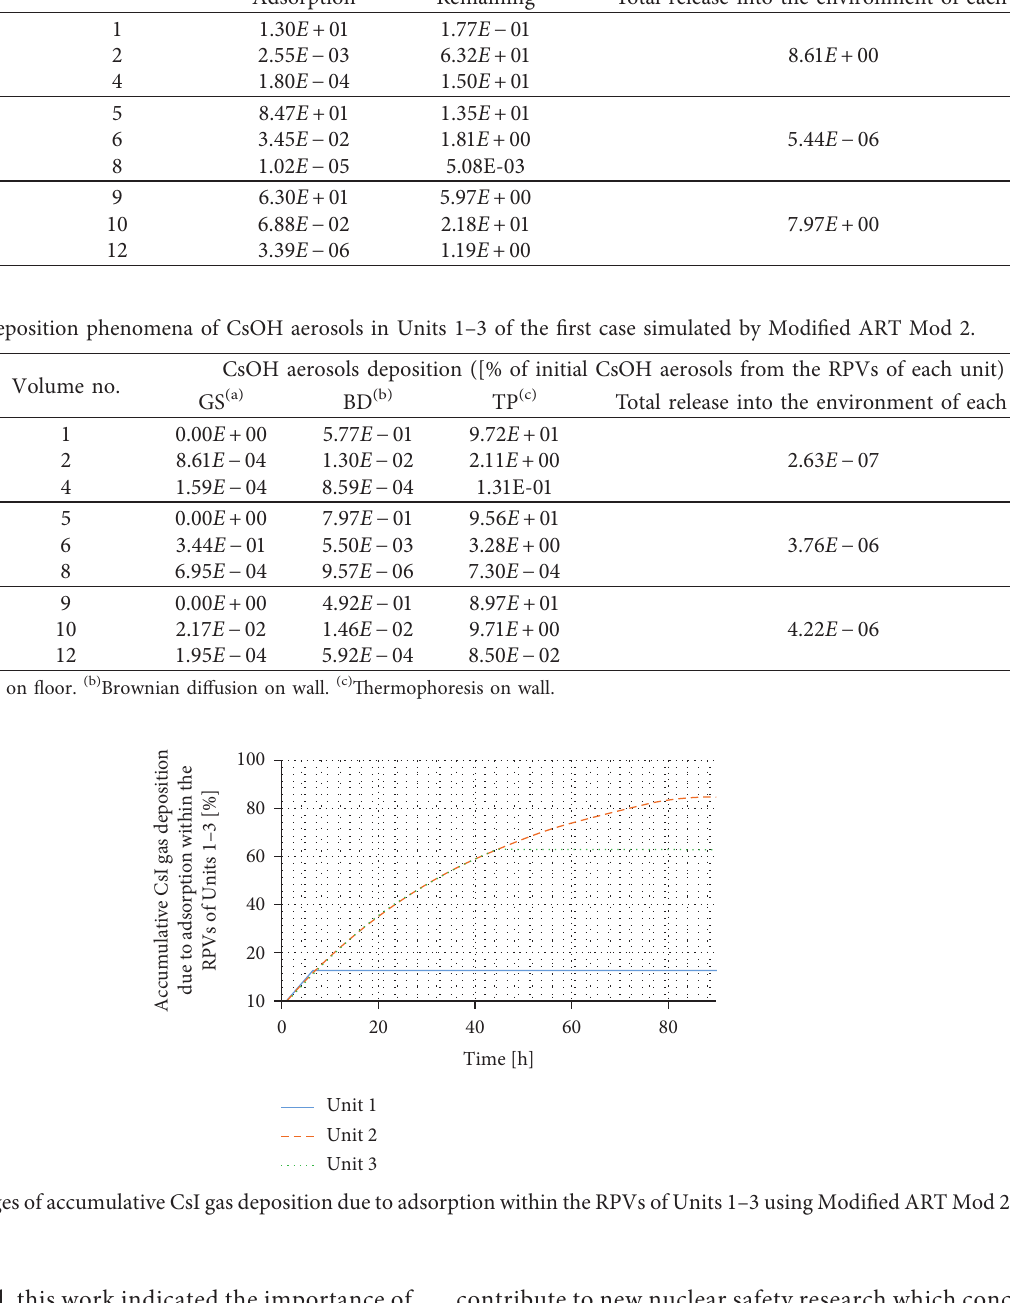
Table 5: Deposition phenomena of CsI gas in Units 1–3 of the first case simulated by Modified ART Mod 2. Unit Type Volume no.